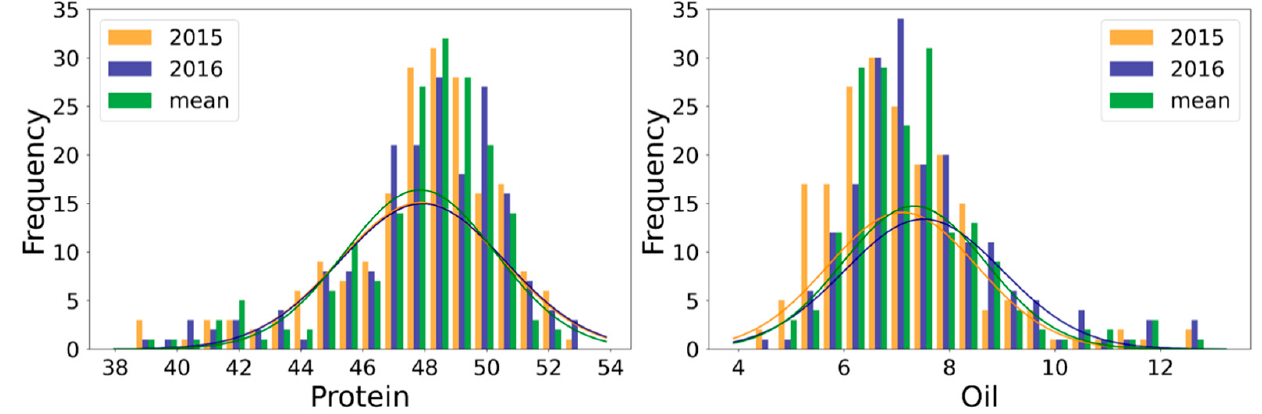
Figure 1. Distribution of protein and oil content in 203 wild soybean accessions. The contents of 17 amino acids, including Met and Cys, varied widely among the 203 wild soybean accessions (Table 2). Of these 17 amino acids, Glu was the main com- ponent of soybean seeds, with an average content of 7019 mg, while Cys had the lowest average content at 348 mg (Table 2 and Figure 2). On the other hand, Cys had the largest coefficient of variation with an average of 14%, but Thr had the lowest with an average of 4.9%. Arginine (Arg) had the highest h 2 (0.71), while Met had the lowest (0.35). Table 2. Descriptive statistics for the amino acid contents in 2015 and 2016. 6001